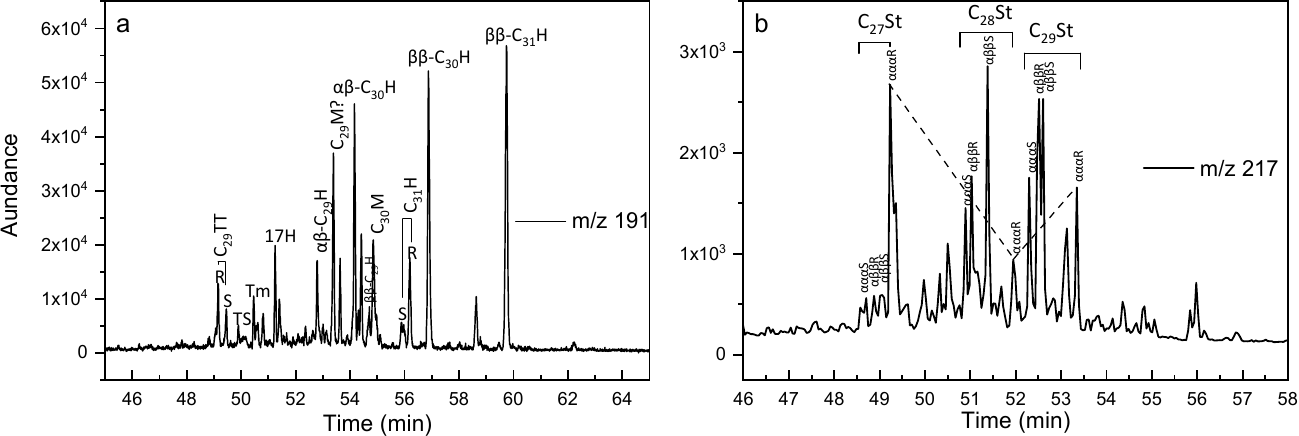
Figure 5. ( a ) Distributions of terpane and hopanes on the mass chromatograms (m/z 191). Peak assignments: TT—tricyclic terpane; H—hopane; M—moretane; Ts—18 α (H)22,29,30-trisnorhopane; and Tm—17 α (H)-22,29,30-trisnorhopane. R, S: the configuration of the compounds. ( b ) Distributions of the diasteranes and regular steranes on the mass chromatograms (m/z 217).